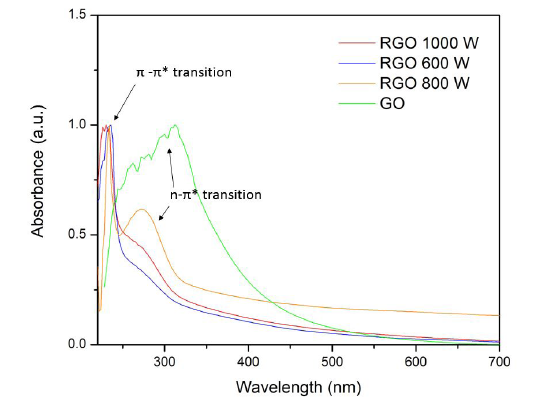
Figure 4. UV-Vis spectra of the materials produced.